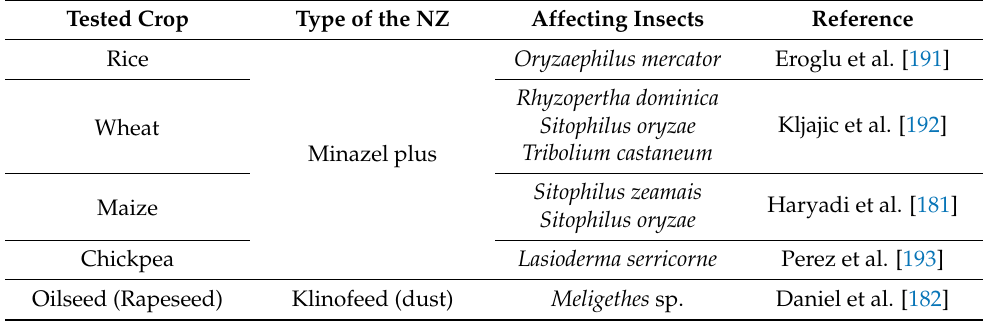
Table 4. Efficacy of Natural Zeolites on Stored—Product